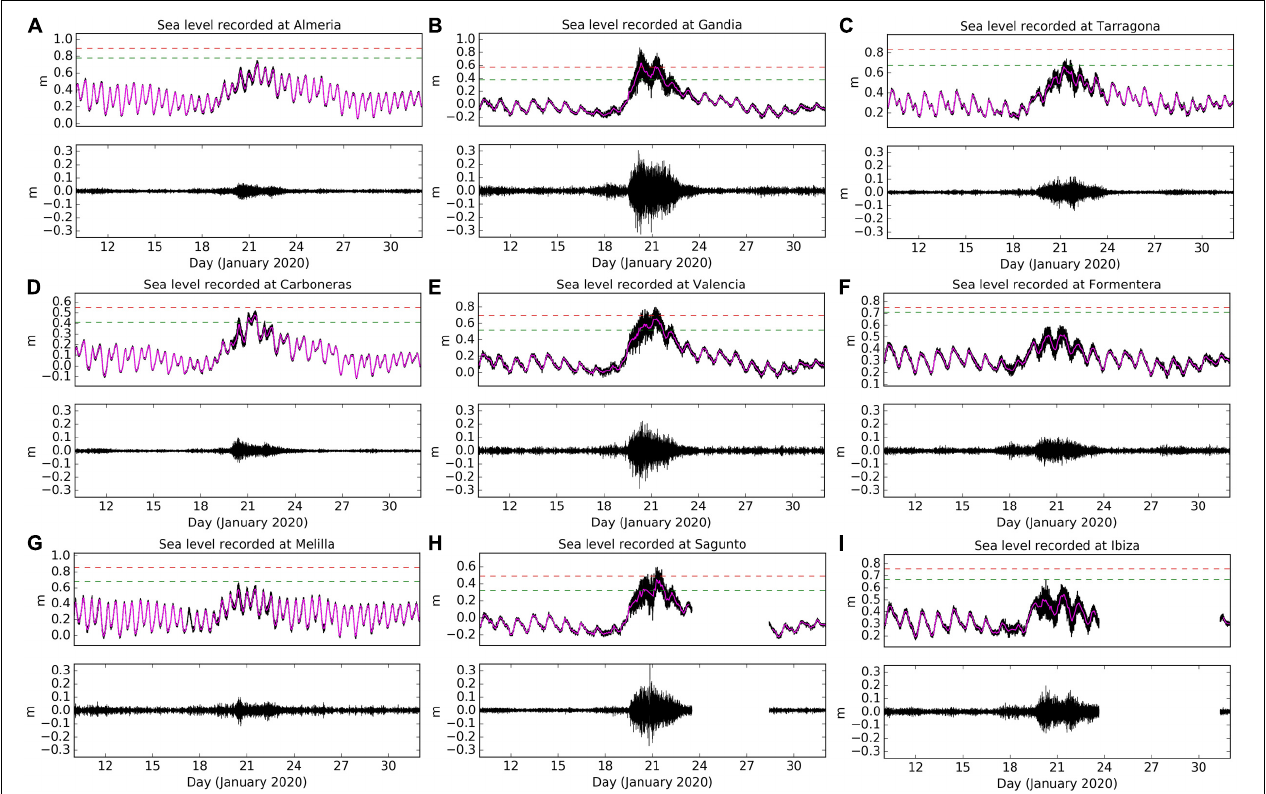
FIGURE 2 | Sea levels recorded during storm Gloria by TGs at Almería (A) , Gandía (B) , Tarragona (C) , Carboneras (D) , Valencia (E) , Formentera (F) , Melilla (G) , Sagunto (H) , and Ibiza (I) . Upper plots for each station show: 1-min data (black), hourly data (magenta), 99th percentile (green line) and 99.95th percentile (red line). Sea levels are referred to each Tide Gauge Datum (TGD). Bottom plots for each station show 1-min high-pass filtered data (same scale for all the stations).